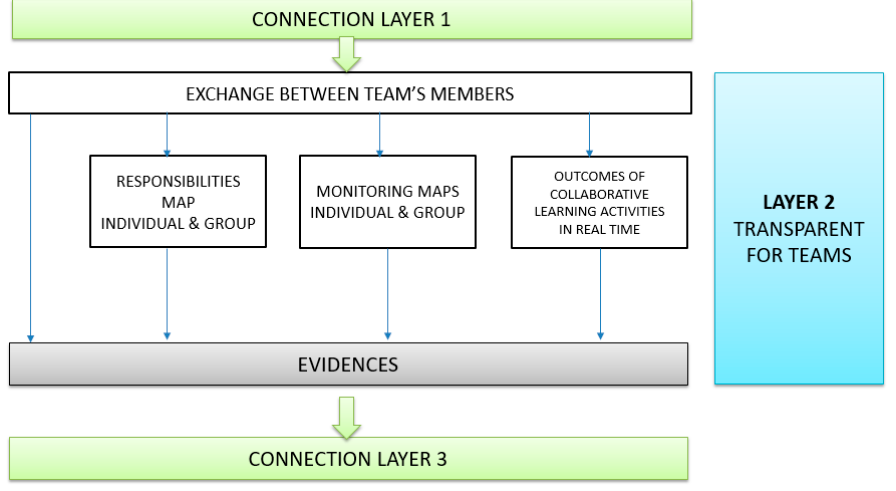
Figure 2. Functional model of layer 2.